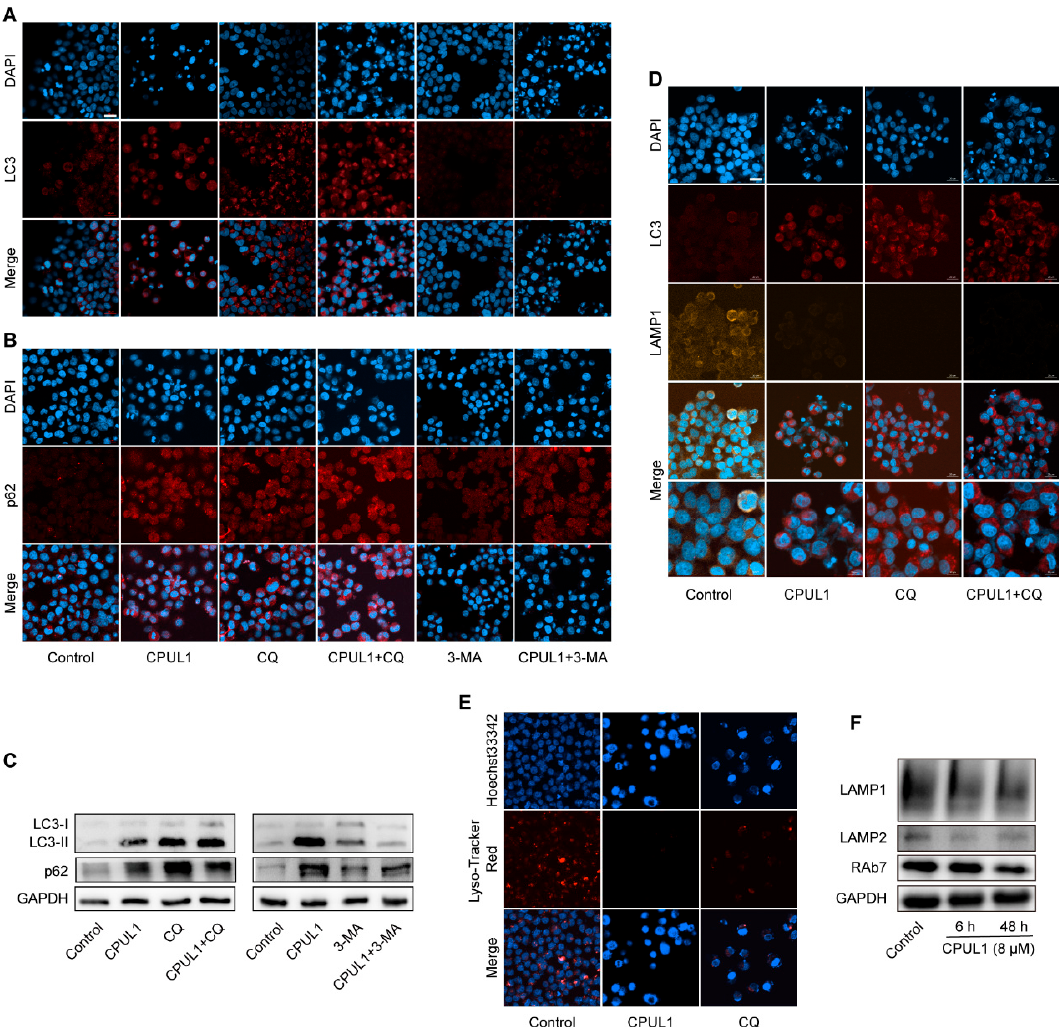
Figure 9. CPUL1 interferes with lysosomal function and fusion with autophagosomes. ( A , B ) The cells were treated with CPUL1 (8 μ M) and 3-MA (2 mM) or CQ (20 μ M) for 48 h, immunolabeling with the p62 and LC3 antibodies. DAPI (blue) was used to stain the nuclei, and the fluorescent images were observed with laser scanning confocal microscopy and processed using the ZEN imaging software. Scale bar = 20 μ m. ( C ) The cells were treated with CPUL1 (8 μ M) and 3-MA (2 mM) or CQ (20 μ M) for 48 h, and the level of LC3-II/I and p62 was detected by Western blotting. ( D ) The cells were treated with CPUL1 (8 μ M) and CQ (20 μ M) for 48 h, and the colocalization of LC3 (667 nm red) and LAMP1 (570 nm orange) was assessed. DAPI (blue) was used to stain the nuclei, and the cells were photographed under a fluorescence microscope. Scale bar = 20 μ m. ( E ) Cells were treated with CPUL1 (8 μ M) and CQ (20 μ M) for 48 h and stained with Lyso-Tracker Red for 60 min, Hoechst 33342 (blue) was used to stain the nuclei and visualized under a fluorescence microscope. Scale bar = 20 μ m. ( F ) Cells were treated with CPUL1 (8 μ M) for 6 h and 48 h, and the levels of RAb7, LAMP1, and LAMP2 were detected by Western blotting.